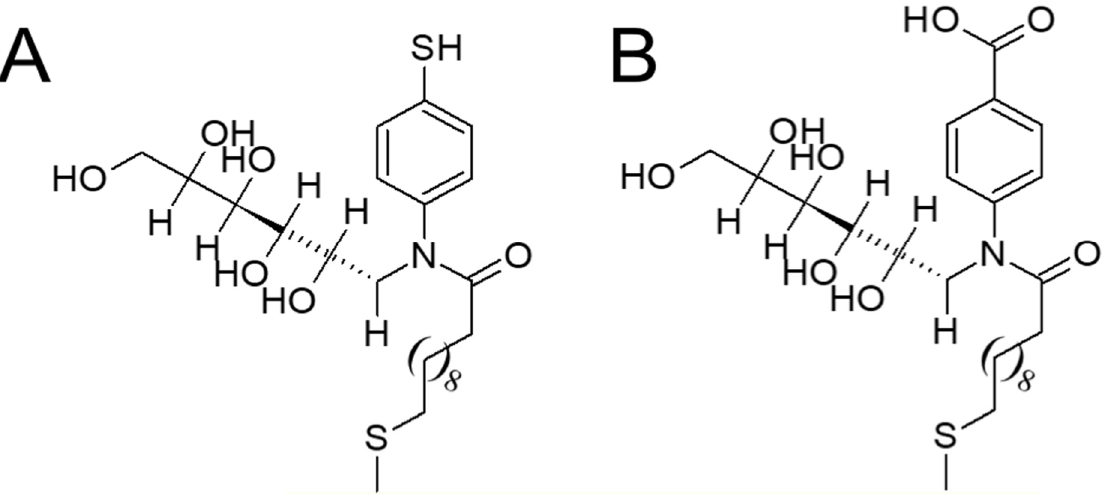
Scheme 1. Schematic representation of immobilized MUA and mannose derivatives on gold quartz crystal. ( A ) 4-TNM ( B )